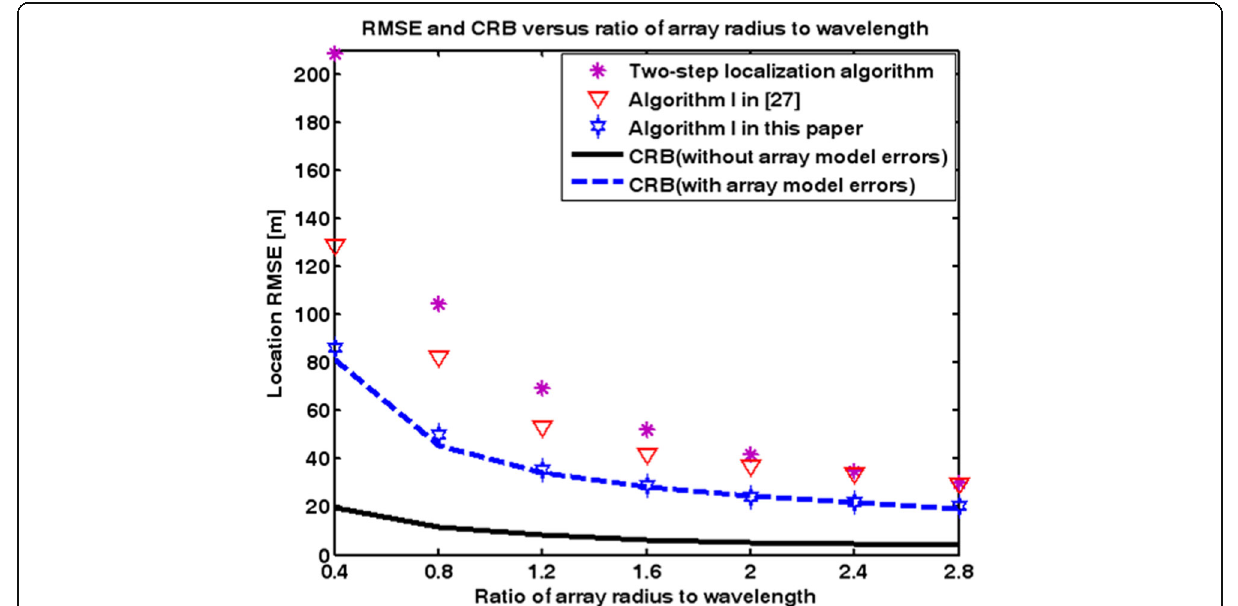
Fig. 5 RMSEs of localization methods and the corresponding CRBs as a function of ratio of array radius to wavelength for case of unknown signal